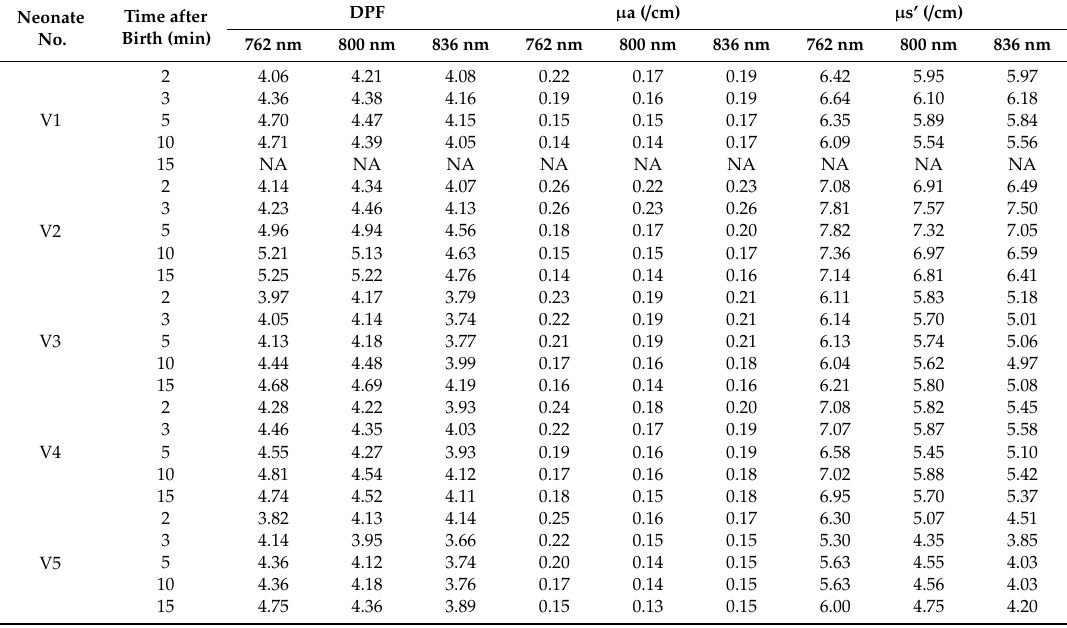
Table 3. The characteristics of the mean value of DPF, µ a, and µ s’ in all neonates. Neonate